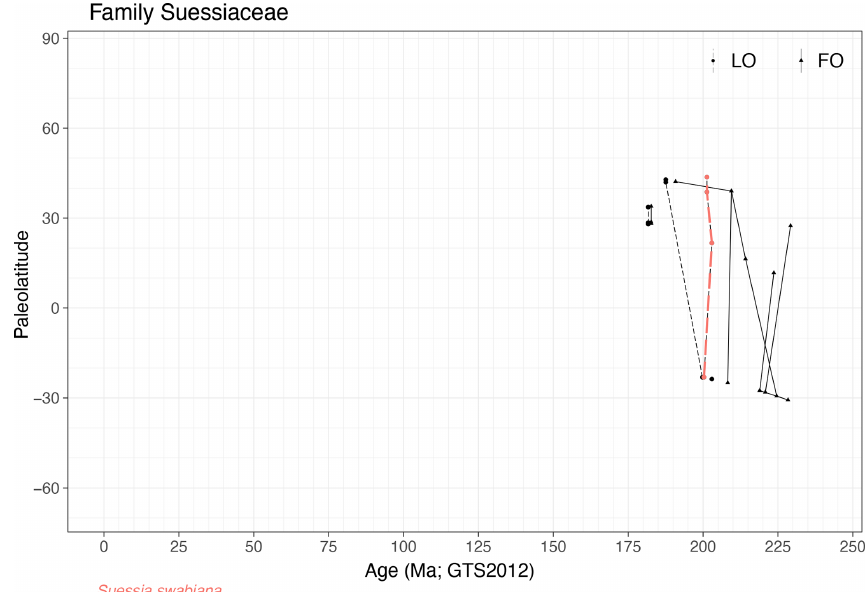
Figure 28. Same as Fig. 5 but for the family